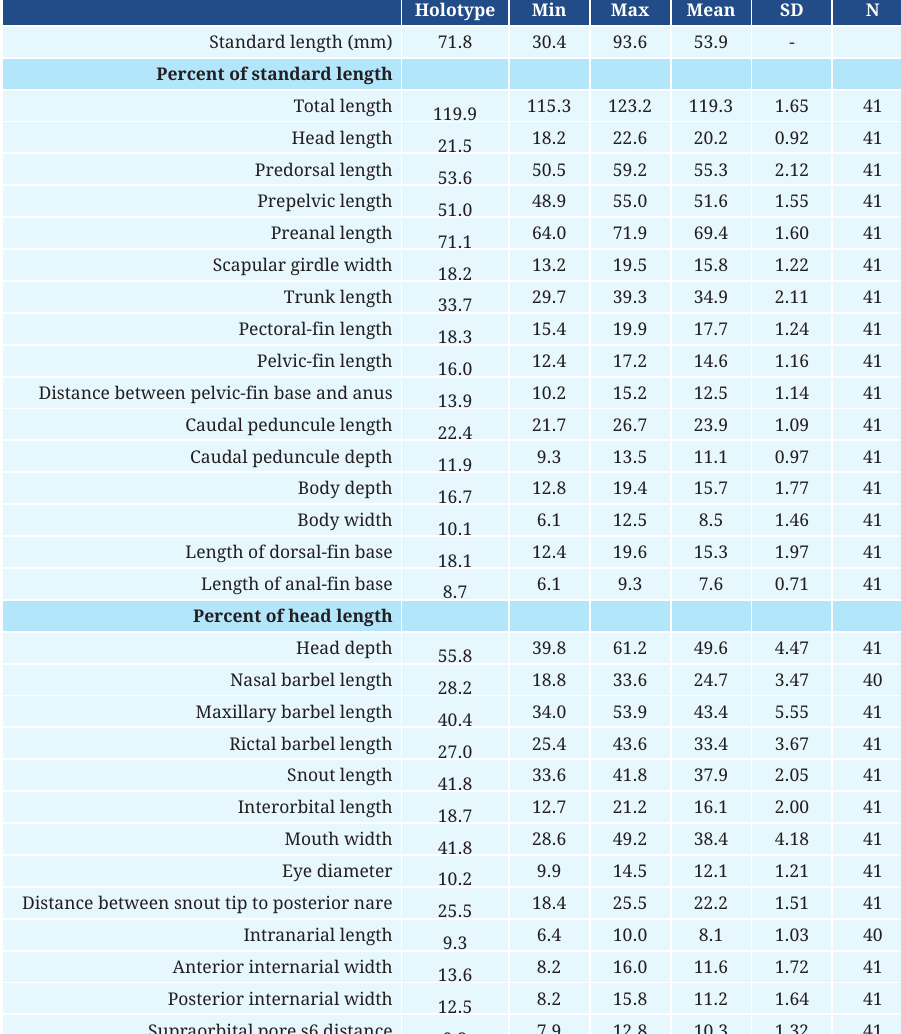
TABLE 5 | Morphometric data of Scleronema macanuda , new species (data of holotype included in the range). N = number of specimens; SD = standard